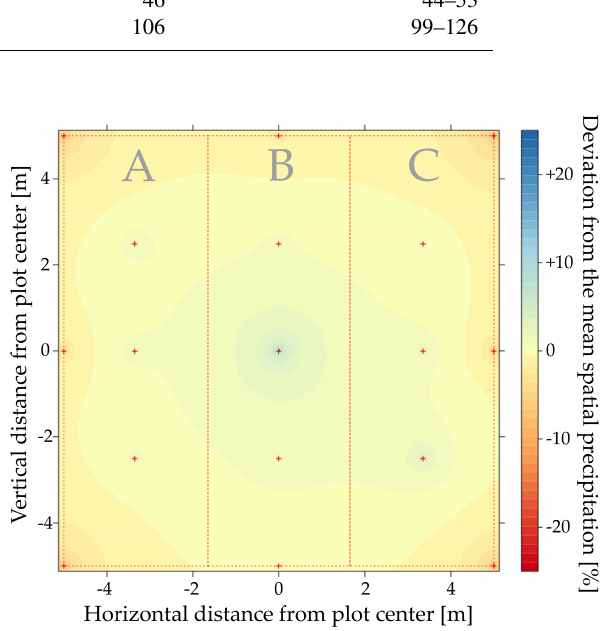
Figure 4. Interpolated rainfall distribution from all 132 experiments as a deviation from the spatial mean in